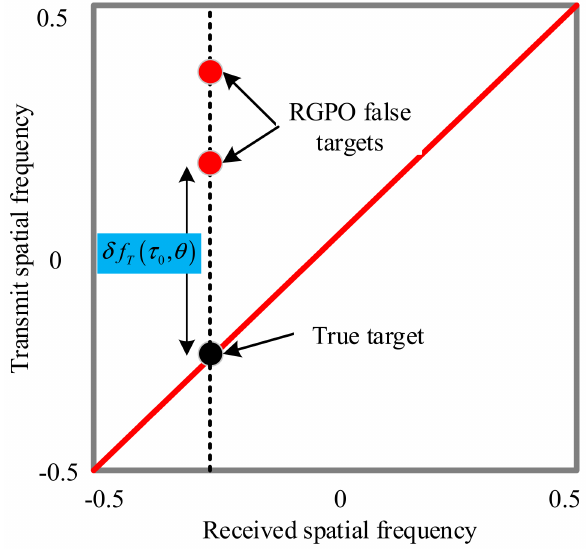
Figure 2. Spectrum position of true and false targets in joint transmit–receive spatial